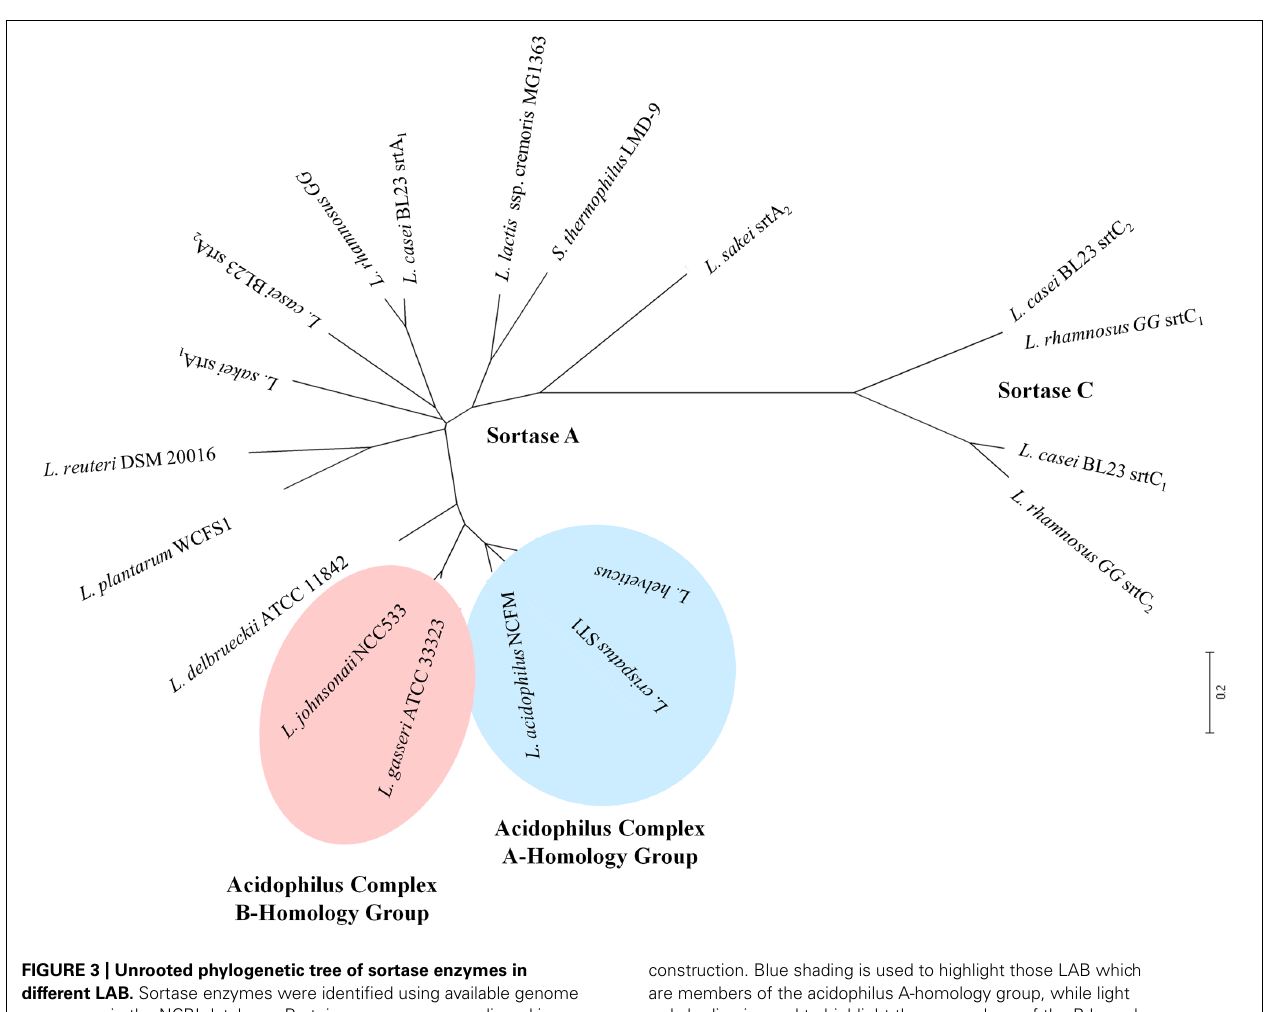
FIGURE 3 | Unrooted phylogenetic tree of sortase enzymes in different LAB. Sortase enzymes were identified using available genome sequences in the NCBI database. Protein sequences were aligned in ClustalX v.2 and then imported into MEGA 4 for phylogenetic tree